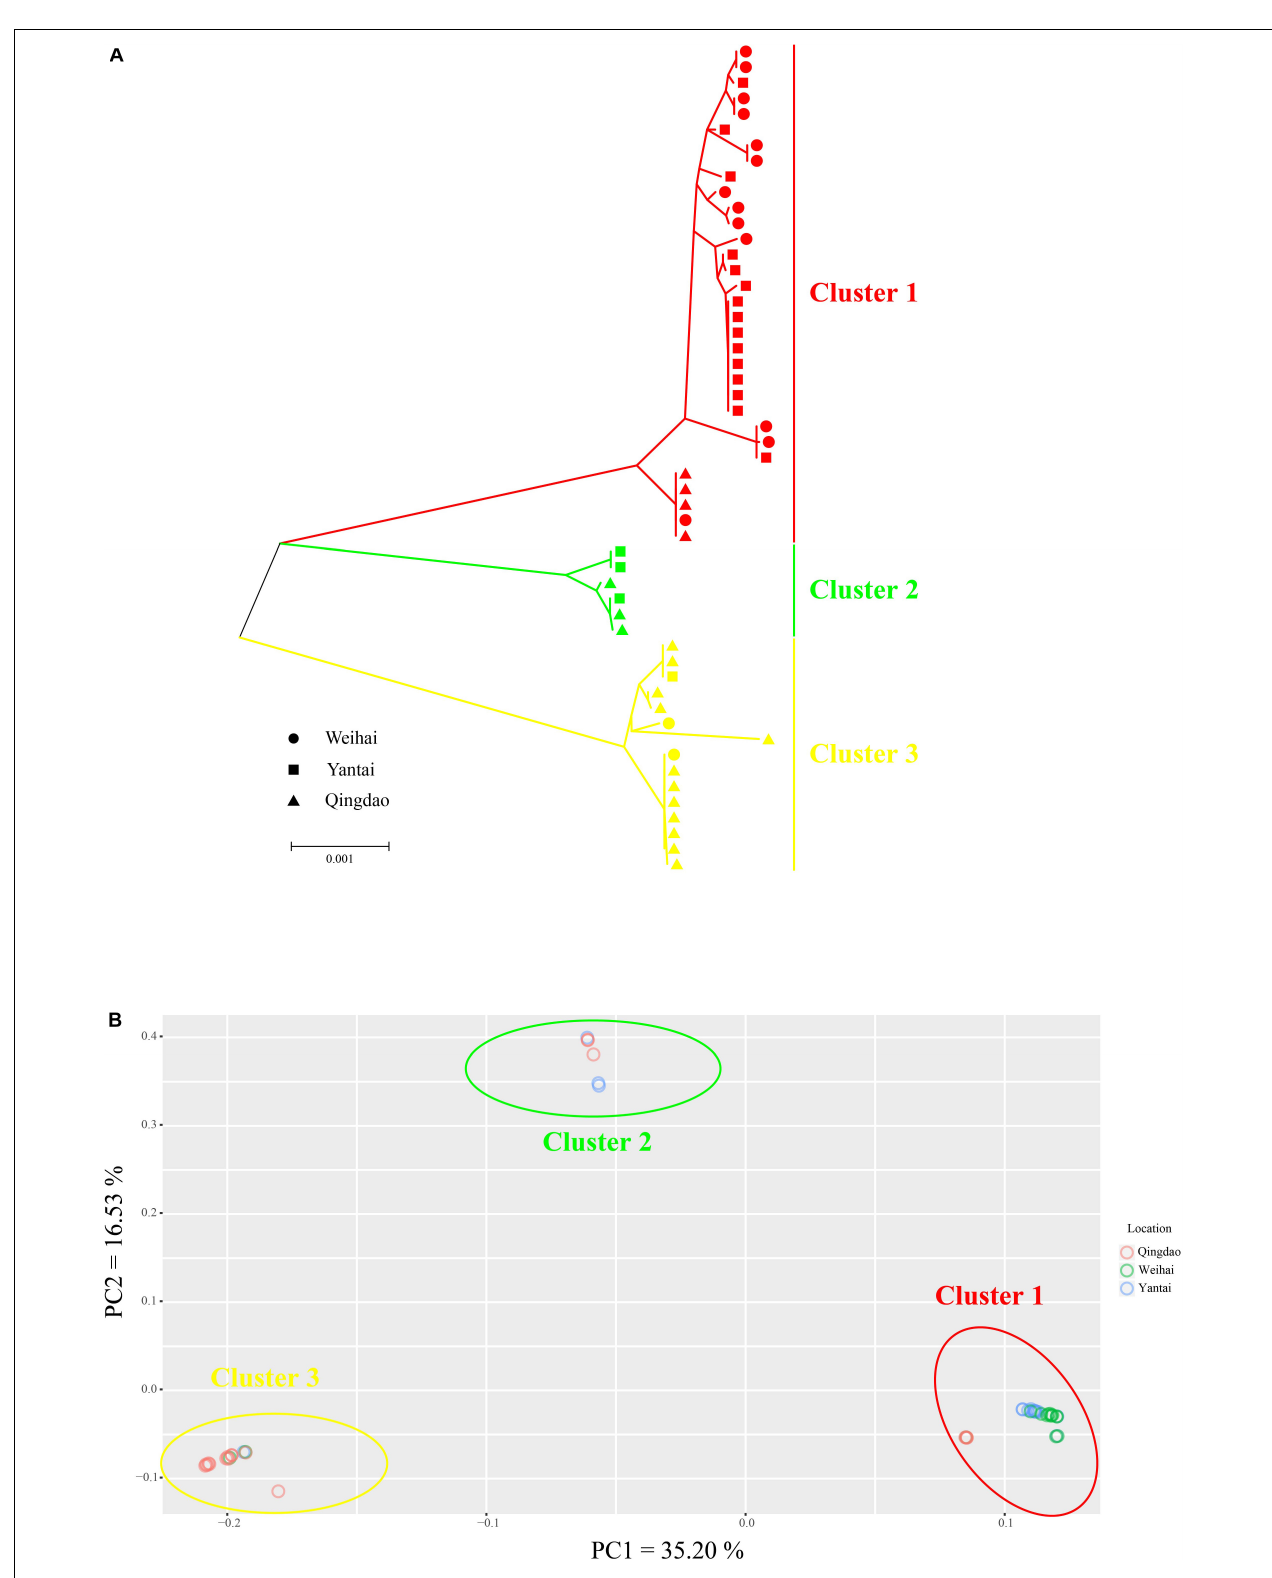
FIGURE 4 | Phylogenetic analysis and principal component analysis (PCA) of the collections. (A) A tanglegram of 53 individuals in three populations of Pyropia yezoensis derived from the neighbor-joining (NJ) method. (B) PCA of all the accessions. The three circles signify the three main groups that were inferred from PCA.